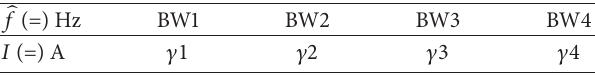
Table 1: Custom frequency bandwidths with their respective cur- rent values for continuous control of the FEB